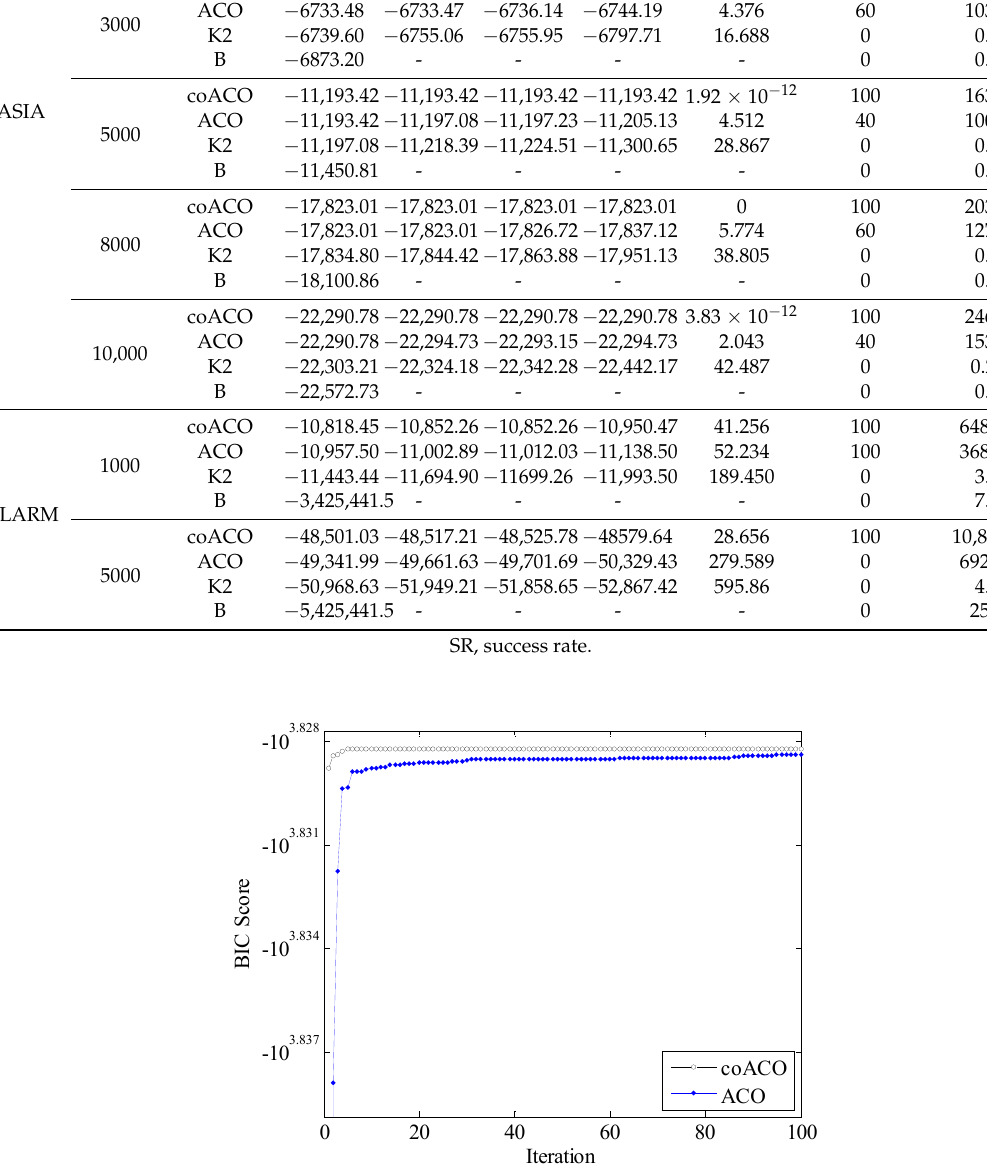
Figure 6. Evolution curves of the average BIC score achieved by ACO and coACO on the ASIA dataset with n = 5000. Figure 7. Evolution curves of the average BIC score achieved by ACO and coACO on the ASIA dataset with n = 8000.